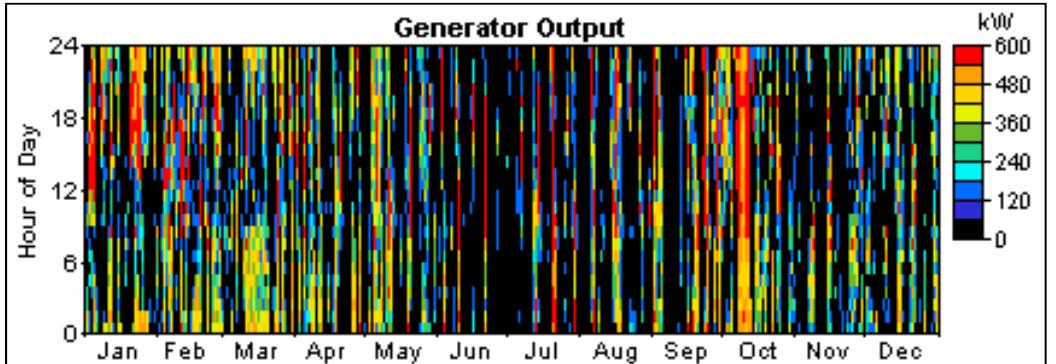
Figure 11. 600 kW diesel generator use in wind/diesel system without VRB